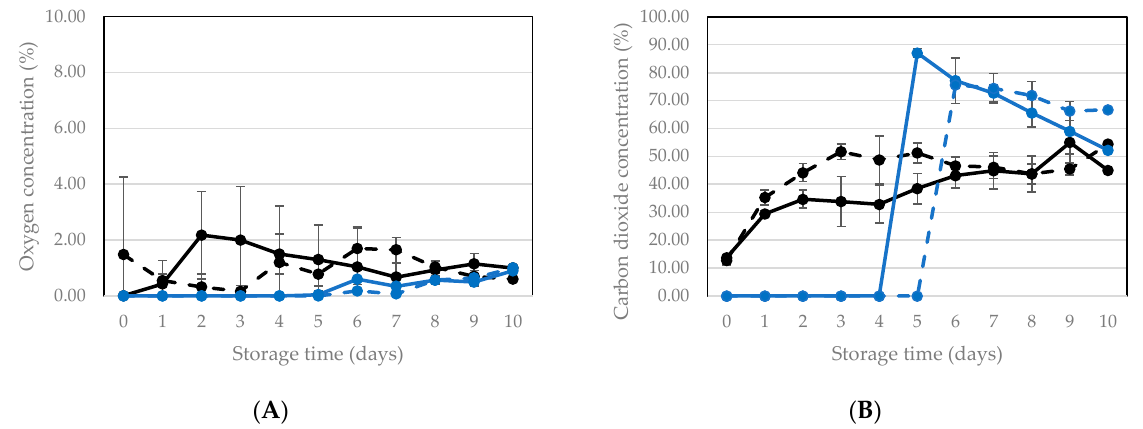
Figure 5. Oxygen ( A ) and carbon dioxide ( B ) concentration during storage at room temperature of packages of living larvae that were only sealed (no vacuum = control) and that were vacuum packaged prior to storage. At day 0 and 1, data points are the mean of 10 packages ( n = 10). Afterwards, each day there was one replicate less, since one package was opened to determine survival. Vertical bars are standard deviations. Two experiments were performed with different batches of larvae: Control 1: black, full line, Control 2: black dashed line, Vacuum 1: blue, full line, Vacuum 2: blue dashed